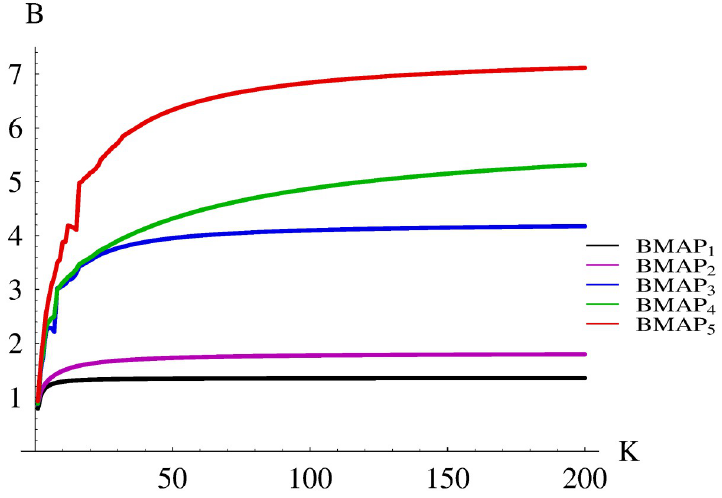
Fig 3. Dependence of the burst ratio on the buffer size for different BMAPs, range 1-200.